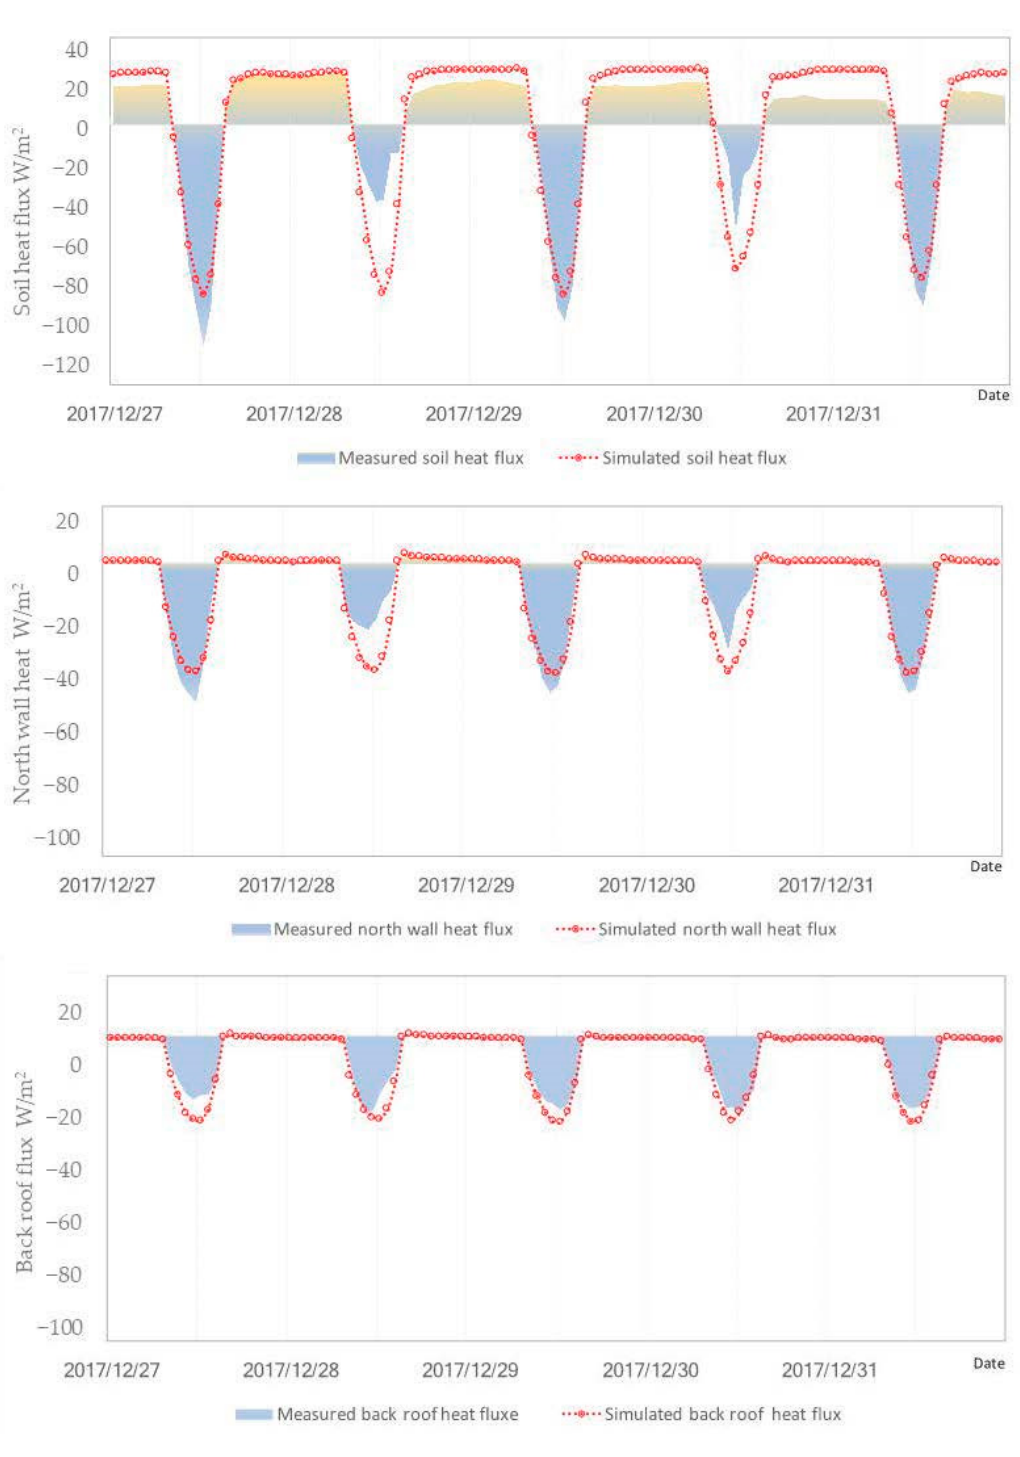
Figure 15. Comparisons of simulated and measured heat flux variations during cloudy days.